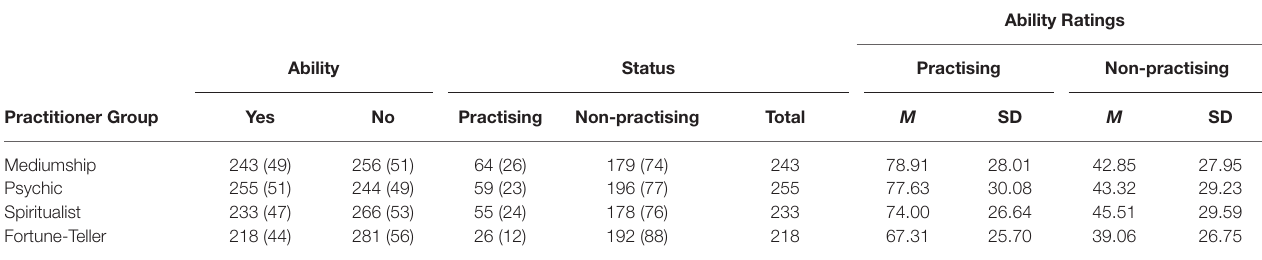
TABLE 1 | Frequencies (and percentages in brackets) of professed ability and practitioner groups.